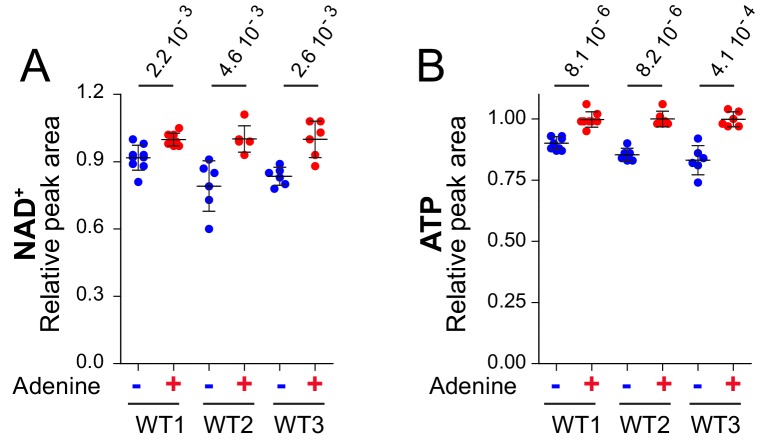
NAD+ and ATP variation in response to adenine availability in wild-type strains.Wild-type (WT1: FY4; WT2: Y286; WT3: BY4742) strains were maintained in exponential growth phase for 24 hr in SDcasaWU supplemented (red dots) or not (blue dots) with adenine. Metabolite extraction, separation and quantification were done as in Figure 2. Quantifications were determined on independent metabolite extractions (N ≥ 5) and standard deviation is presented. The amount of each metabolite measured in cells grown in the presence of adenine (red dots) was set at one and p-values indicated on the top of each panel were determined by a Welch’s t-test.10.7554/eLife.43808.012Figure 2—figure supplement 5—source data 1.Metabolic analyses for different wild-type strains grown in ±adenine.